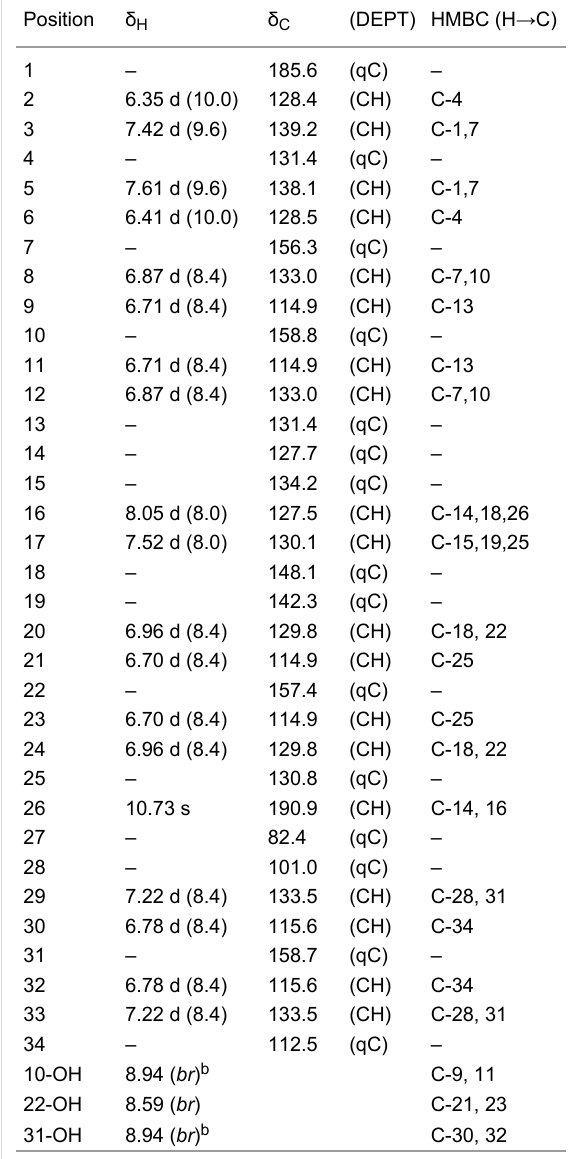
Table 1: 1 H and 13 C NMR data and key HMBC correlations for com- pound 1 . a